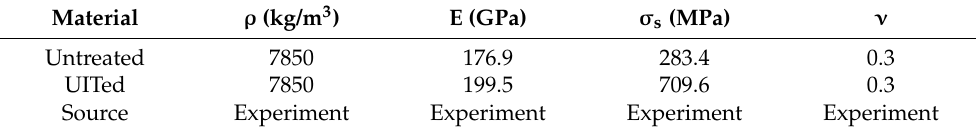
Table 5. Material properties of the thin-walled tube. Material Untreated